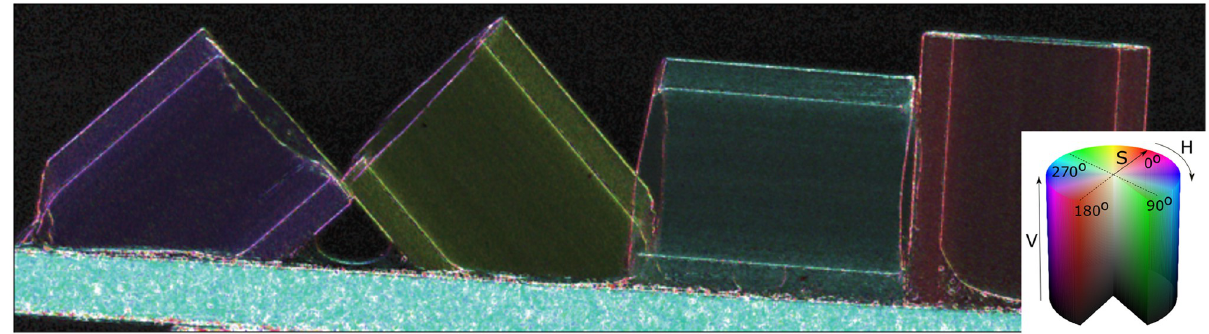
Fig 4. Composite image using the HSV colour space (mapping illustrated with the inset colour-cylinder). The hue H shows the orientation θ of the scattering, saturation S represents the directionality ε , and the value V shows the mean kernel width σ .